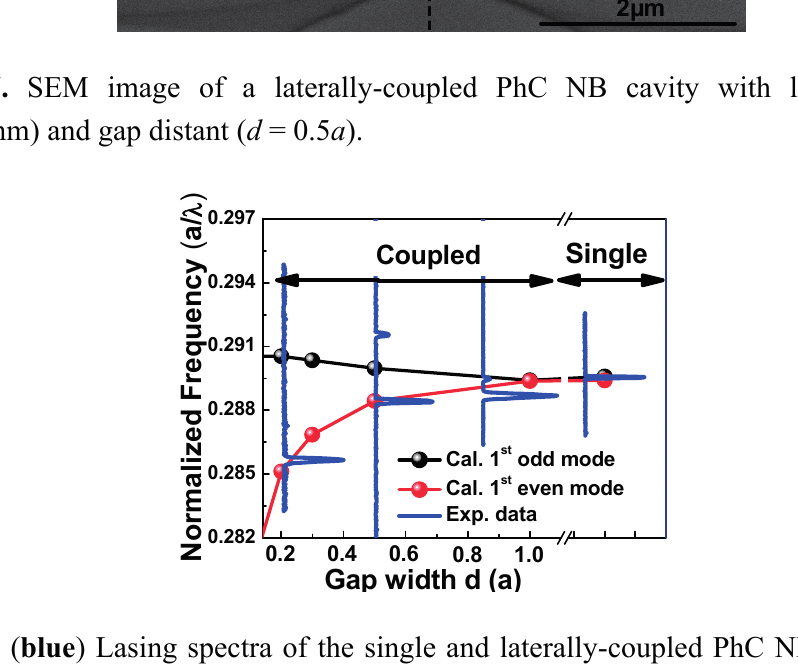
Figure 8. ( blue ) Lasing spectra of the single and laterally-coupled PhC NB cavities with gap width (0.8 a , 0.5 a and 0.26 a ). ( black and red ) the normalized frequencies of first-order odd/even modes from the numerical